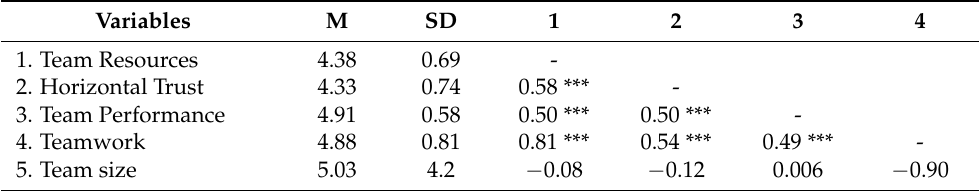
Table 2. Means, standard deviations, and intercorrelations among the study variables at the team level (N = 177).